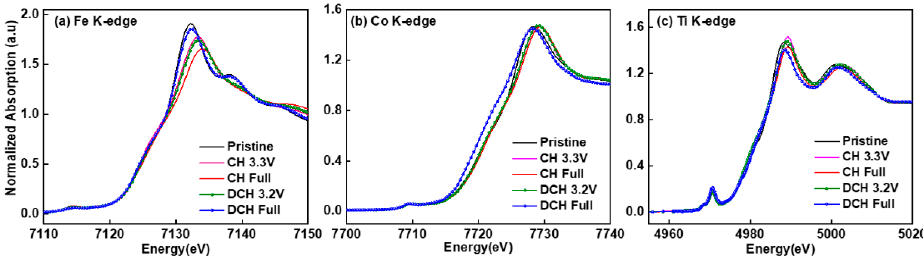
Figure 4. Normalized ex situ XANES spectra of the NFCTO electrode at ( a ) Fe, ( b ) Co and ( c ) Ti K-edges at various charge and discharge states.